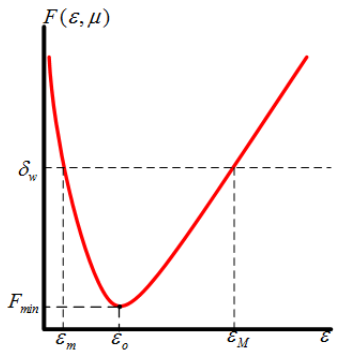
Figure 4. The changes of the extremum of estimation